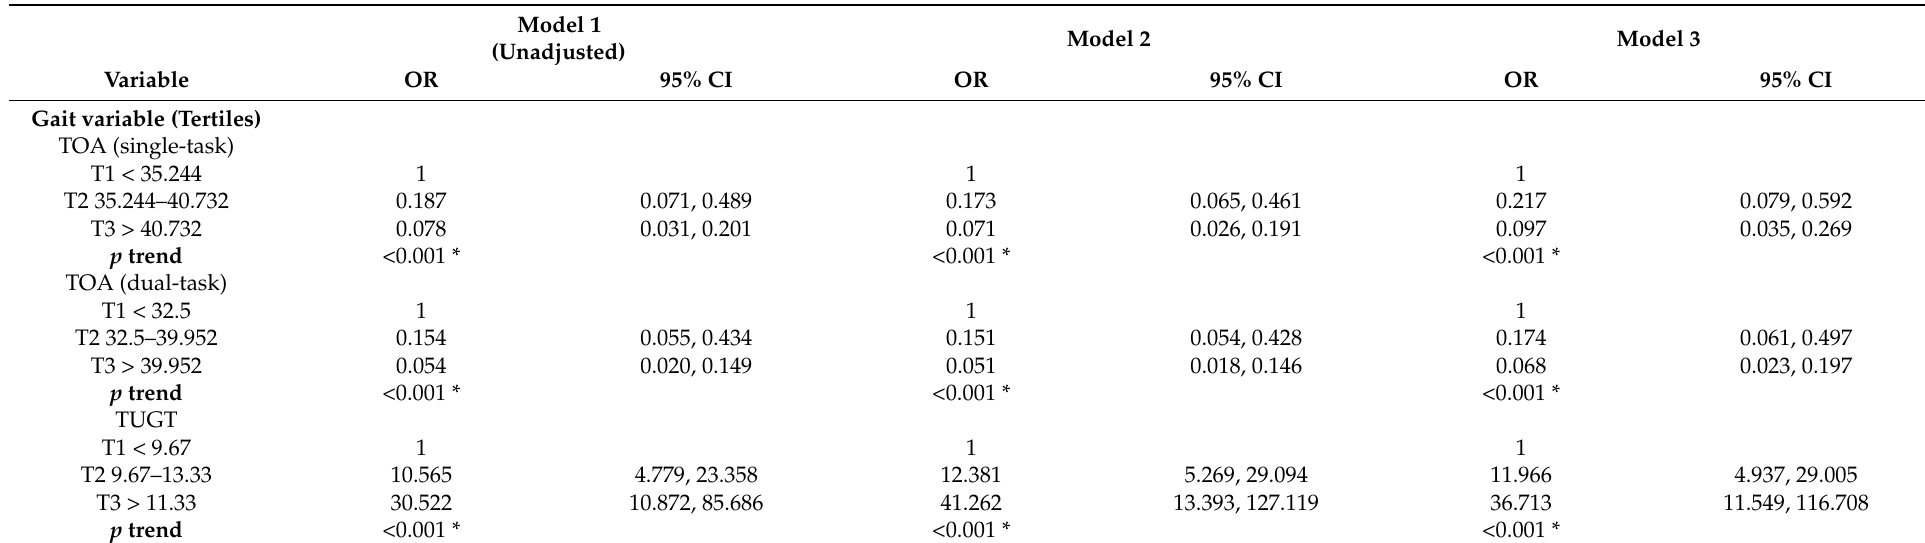
Table 4. Logistic regression analyses on associations among TOA, TUGT, and risk of cognitive